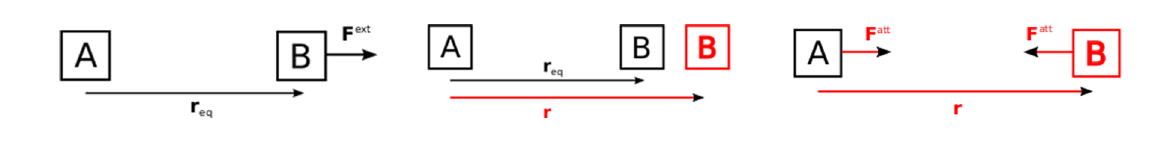
Figure 2: From left to right: An external pulling force acting on the system in its equilibrium structure increases the distance between the subsystems and induces an attractive internal force.